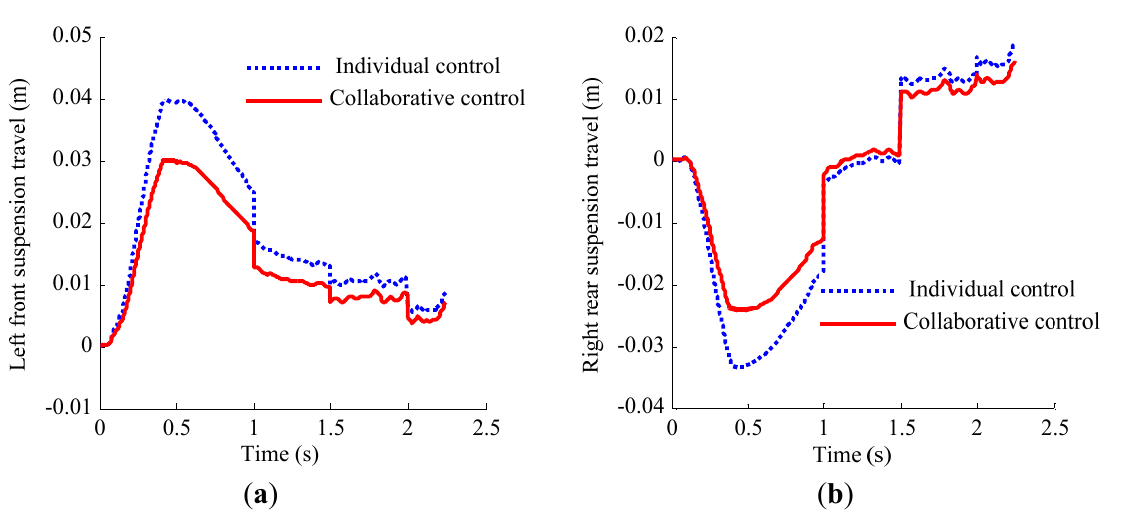
Figure 9. Simulation results of vehicle suspension travel: ( a ) Left front suspension travel; ( b ) Right rear suspension